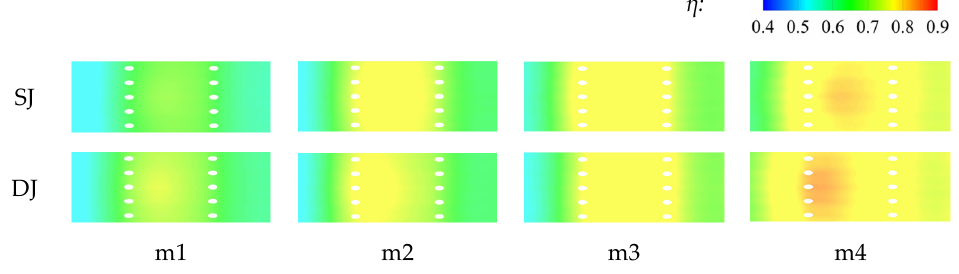
Figure 8. Time-averaged overall cooling effectiveness contours upon the outer surface at α = 30 ◦ . Table 5. The area-averaged overall cooling